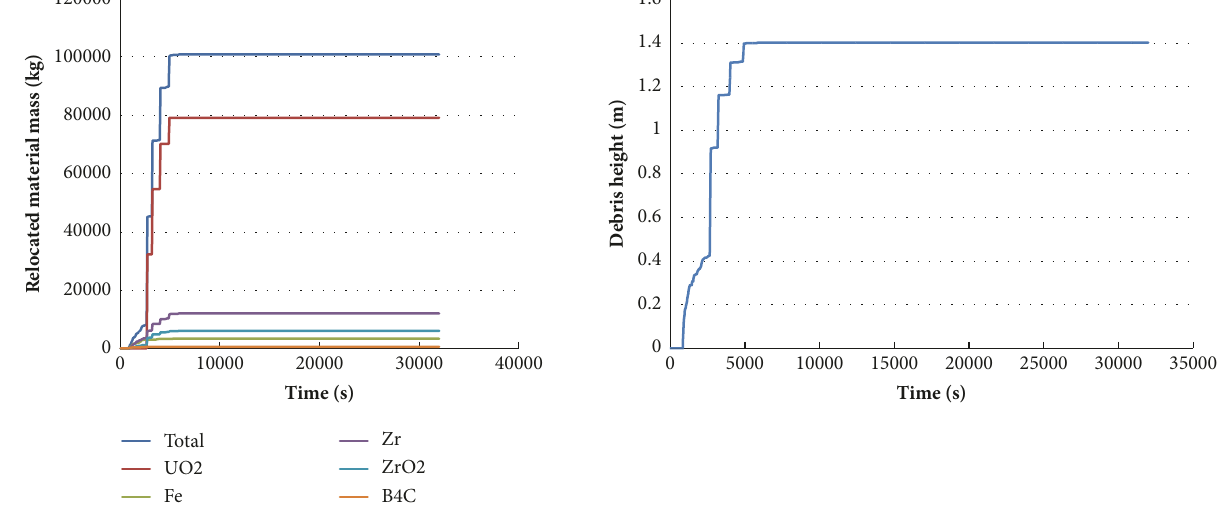
Figure 8: Mass of different materials and debris height in the lower head.